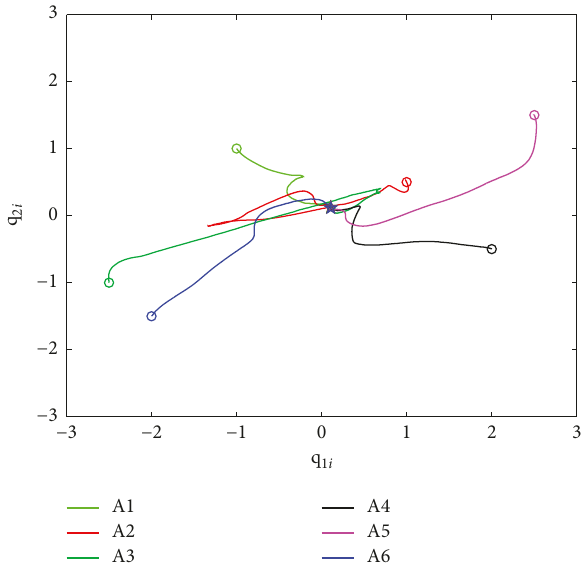
Figure 13: State trajectories and the fault case